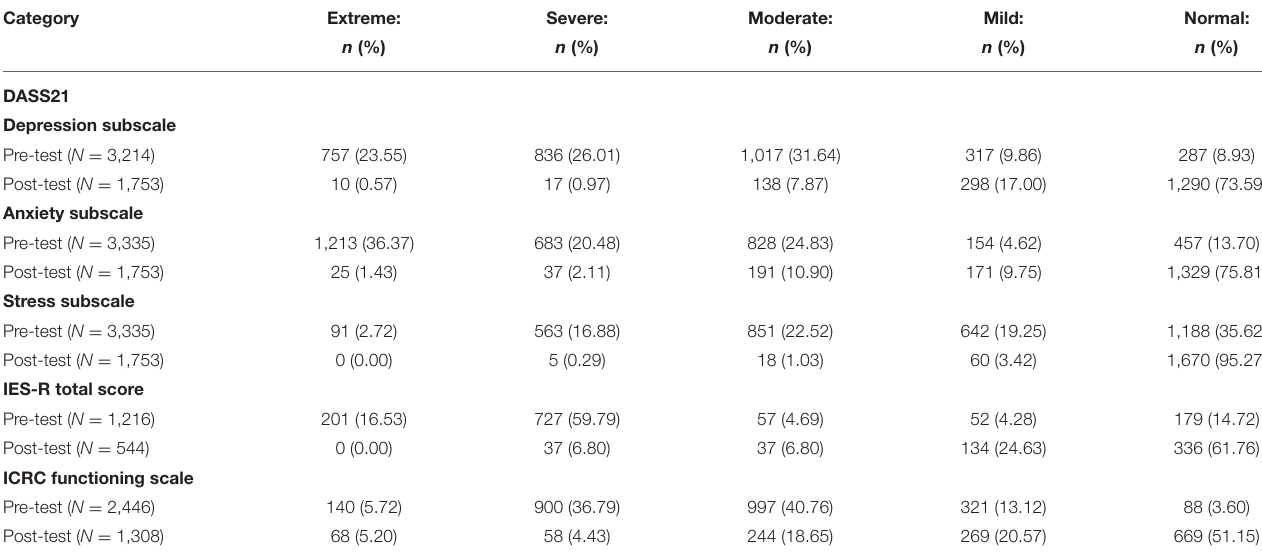
TABLE 2 | Distress and functioning categories.